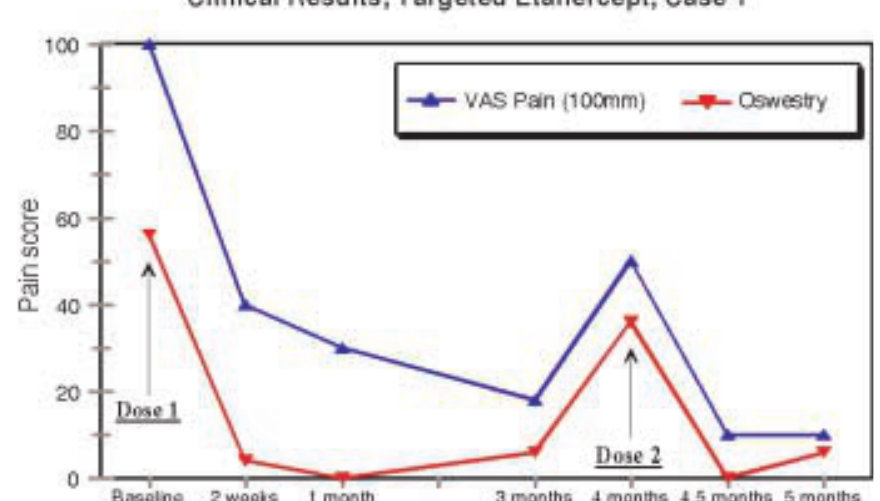
Clinical response to targeted etanercept, case